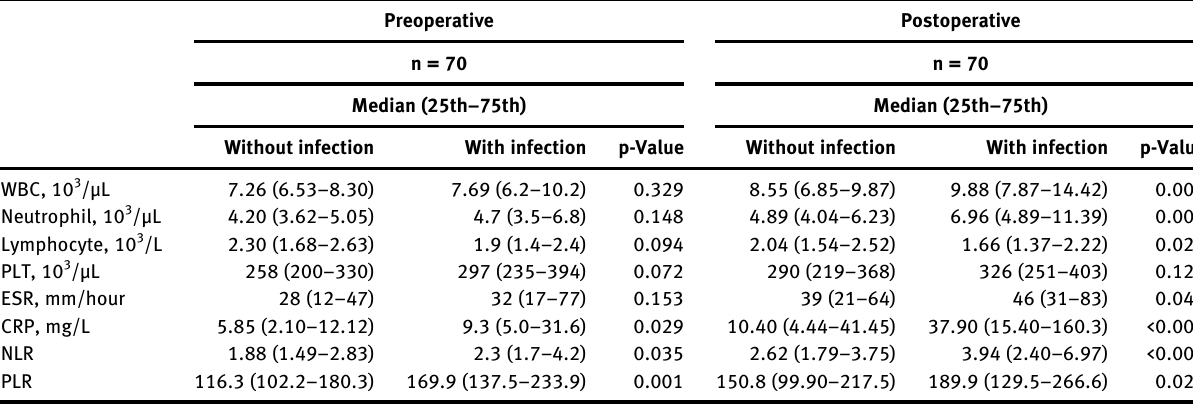
Table  : Comparison of preoperative and postoperative laboratory measurements in patients with and without